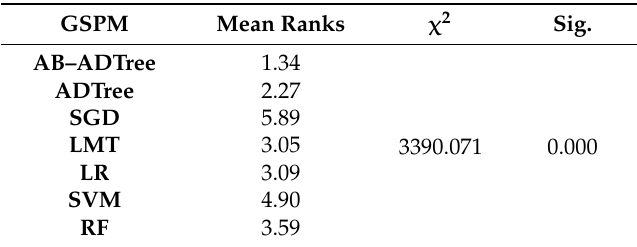
Table 6. Average ranking of the seven groundwater spring potential models (GSPM) using the Friedman test.